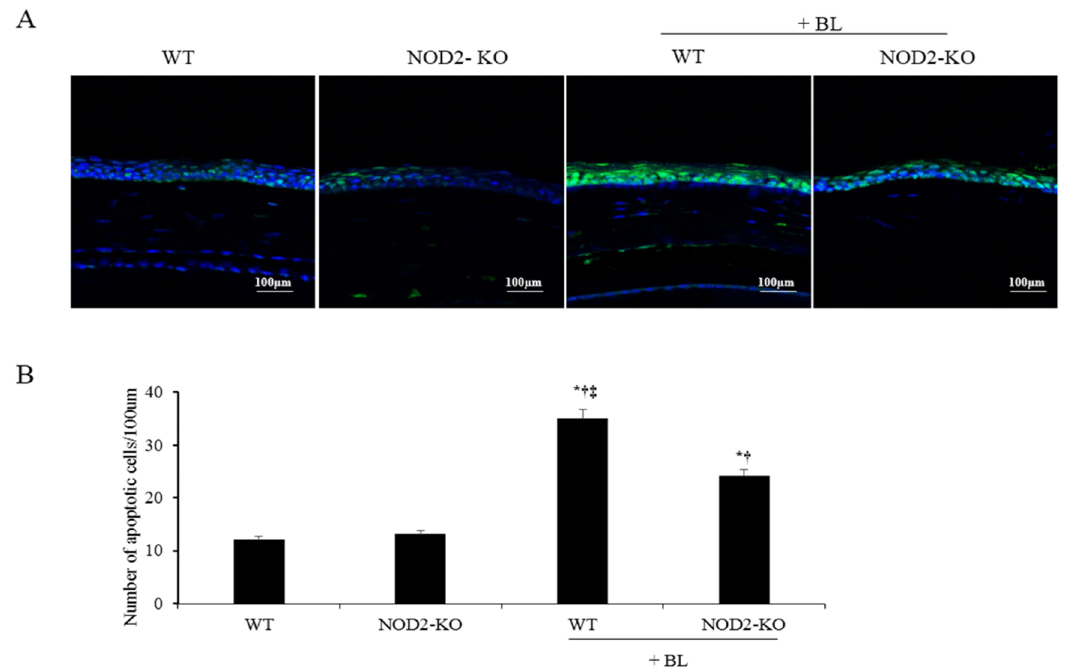
Figure 4. Terminal deoxynucleotidyl transferase-mediated dUTP-nick end labeling (TUNEL) staining of representative photograph ( A ) and the mean number of TUNEL-positive cells ( B ) in the cornea of the WT, NOD2-KO, WT+BL, and NOD2-KO+BL groups, after 10 days of blue light exposure. * p < 0.05 vs. WT; † p < 0.05 vs. NOD2-KO; ‡ p < 0.05 vs. WT + BL. WT, wild type; BL, blue light; NOD2-KO, nucleotide-binding oligomerization domain 2